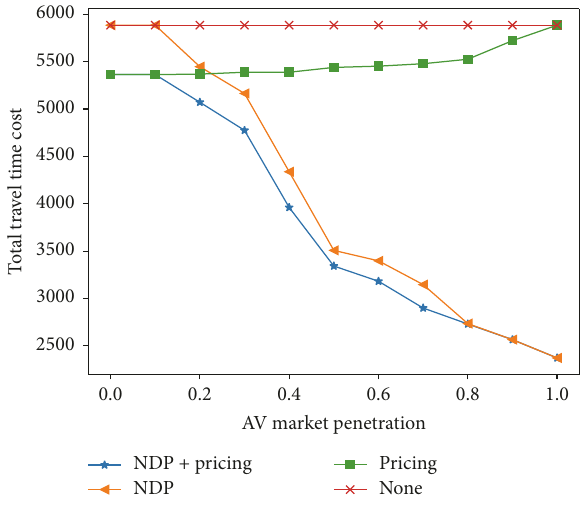
Figure 5: Four models at different AV market